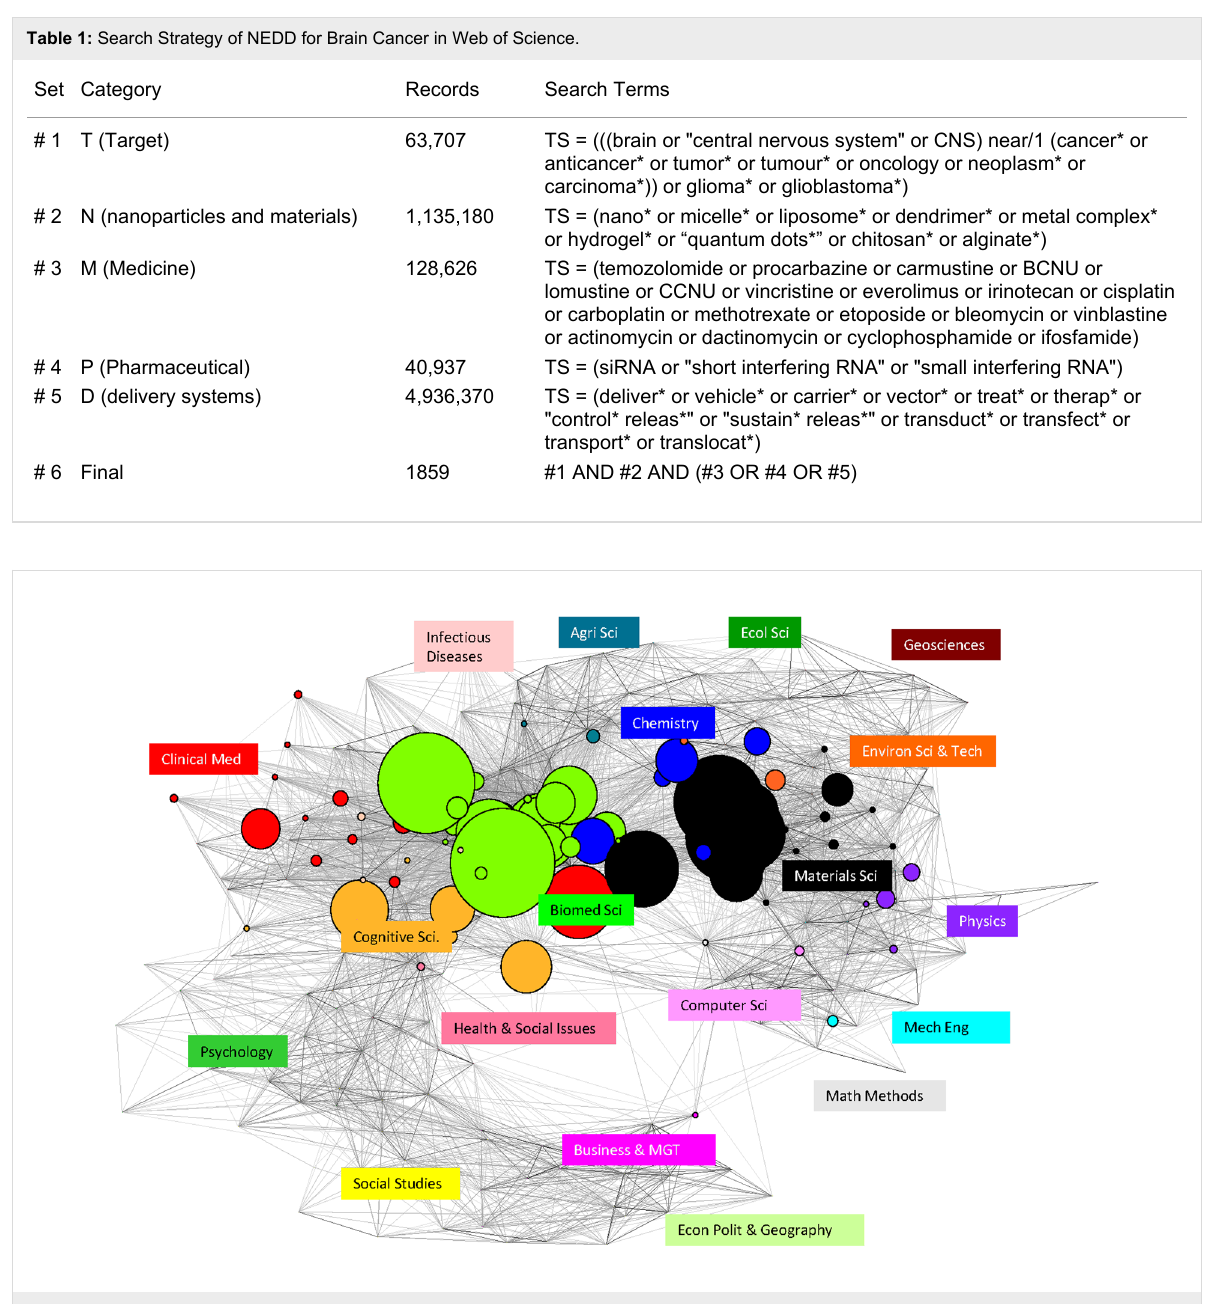
Figure 1: NEDD for brain cancer research across the disciplines.